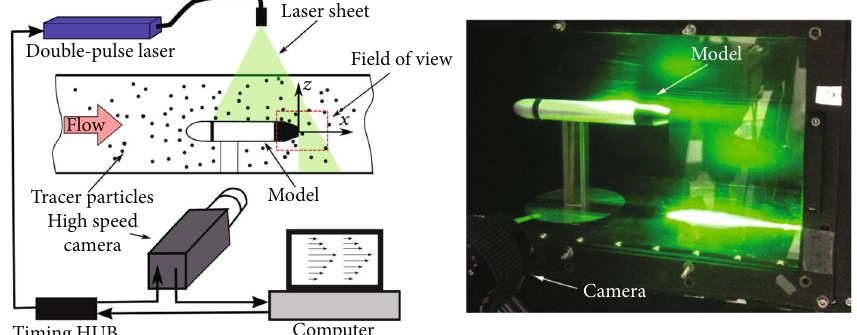
Figure 2: PIV set-up and model in